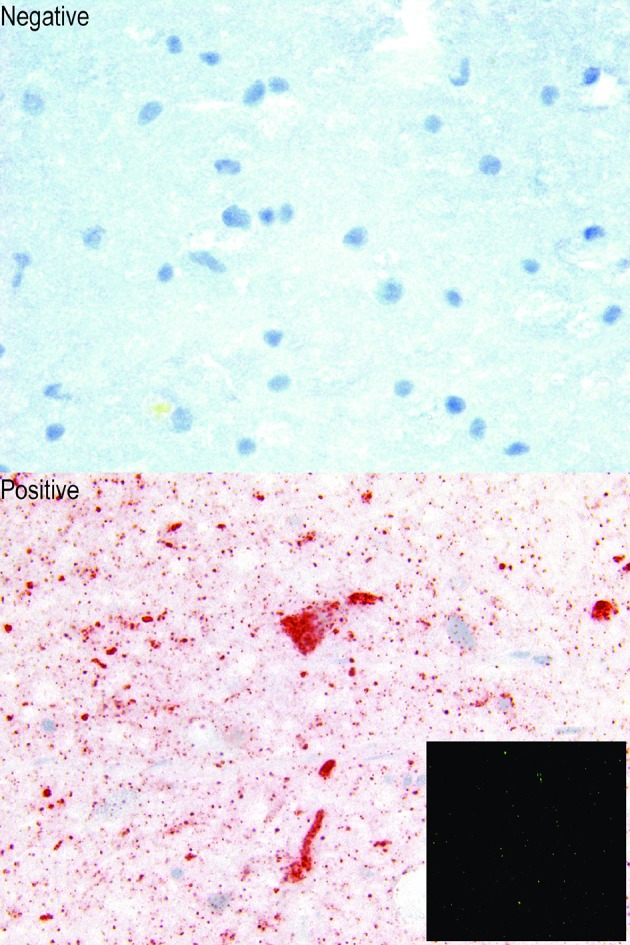
Comparison of RIADacetone test with FAT (inset) on canine brain smears infected with rabies virus (positive) or not (negative).The presence of RABV antigen is indicated by brick red deposits (Positive) or green fluorescence (inset) in brain smears tested using the RIADacetone test or FAT, respectively. Magnification of the RIADacetone images are 63X and the FAT image is 20X. All smears were fixed in acetone.